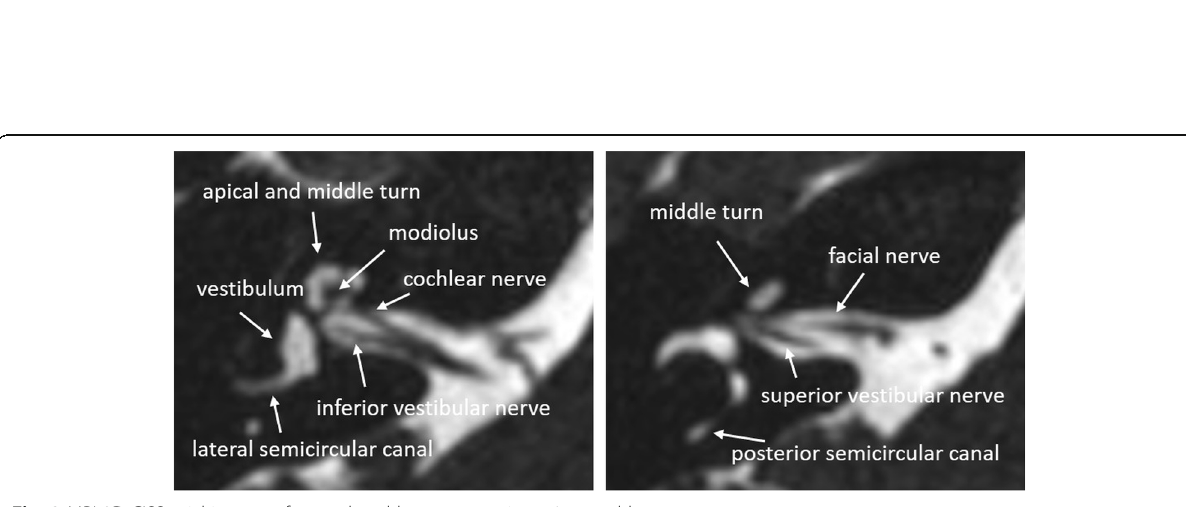
Fig. 3 MRI 3D-CISS axial images of normal cochlear anatomy in a 40-year-old